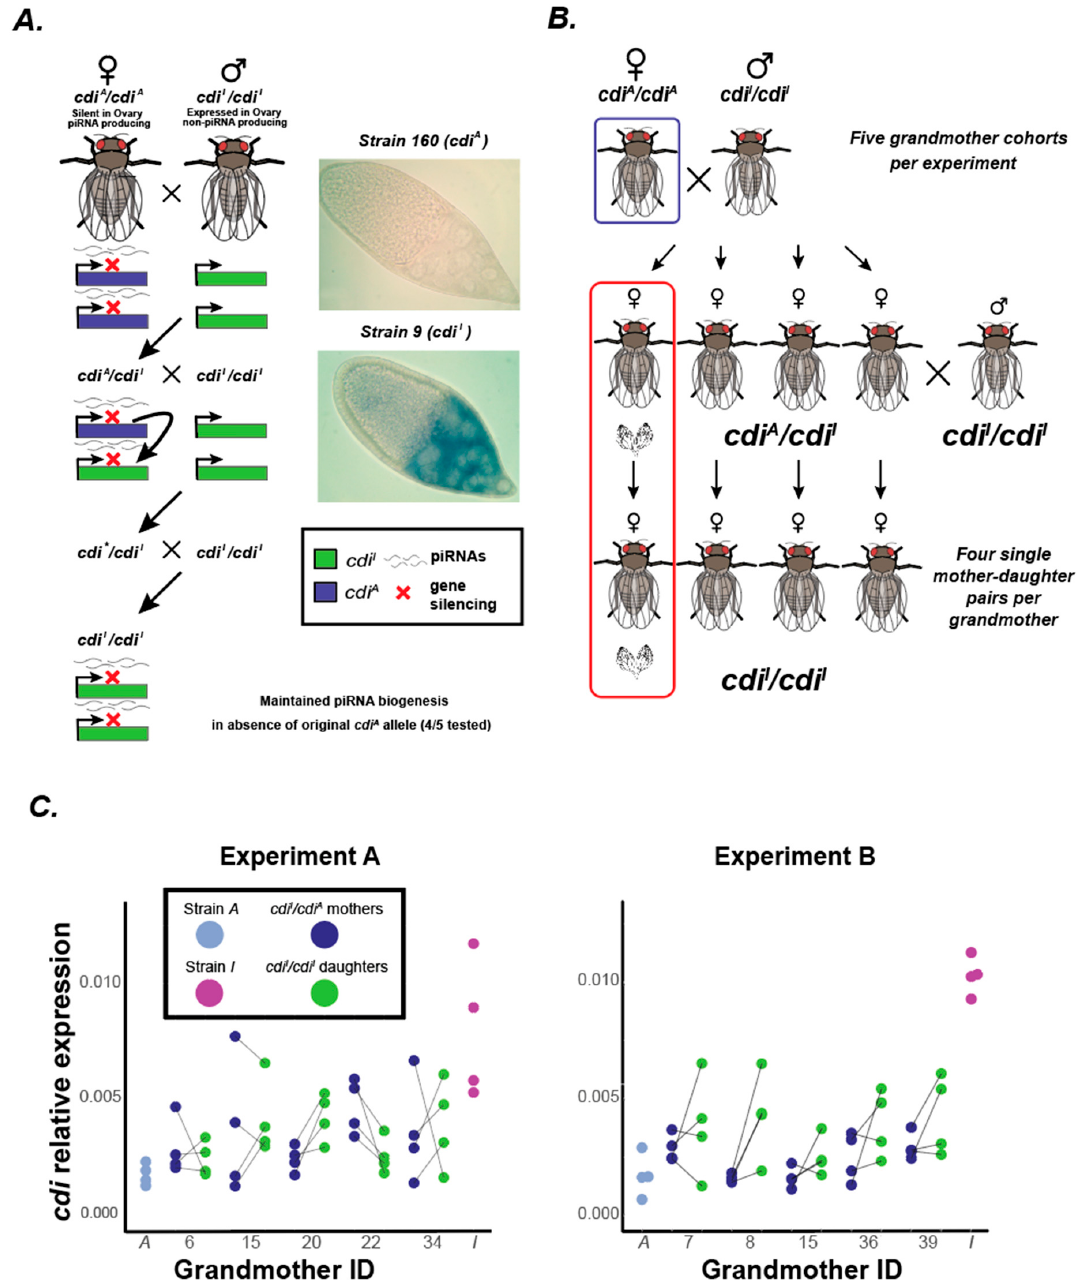
Figure 1. Experimental design and cdi expression. ( A ) The system of piRNA-mediated silencing of cdi by conversion to a dual-strand piRNA cluster. The cdi A allele is silenced and produces piRNAs from both strands. Results from previous studies indicate that a maternally inherited cdi A allele has the capacity to induce piRNA biogenesis from a non-silenced allele in trans . In addition, in subsequent generations, genic piRNA biogenesis can be maintained from cdi in the absence of the original triggering allele. In situ experiments show the expression of cdi in the egg chamber of strain 9 (which carries the expressed cdi I allele) and no expression in strain 160 (which carries the silent cdi A allele). ( B ) Experimental design for a single cohort derived from one of five grandmothers per experiment. ( C ) Low expression of cdi is maintained in the absence of the original triggering allele. Shown are relative expression values for cdi , normalized to Rp49. Each experiment presents the results of five cohorts, each daughter within a cohort being a cousin and uniquely derived from a single mother. Values presented are averages of three technical replicates per individual.